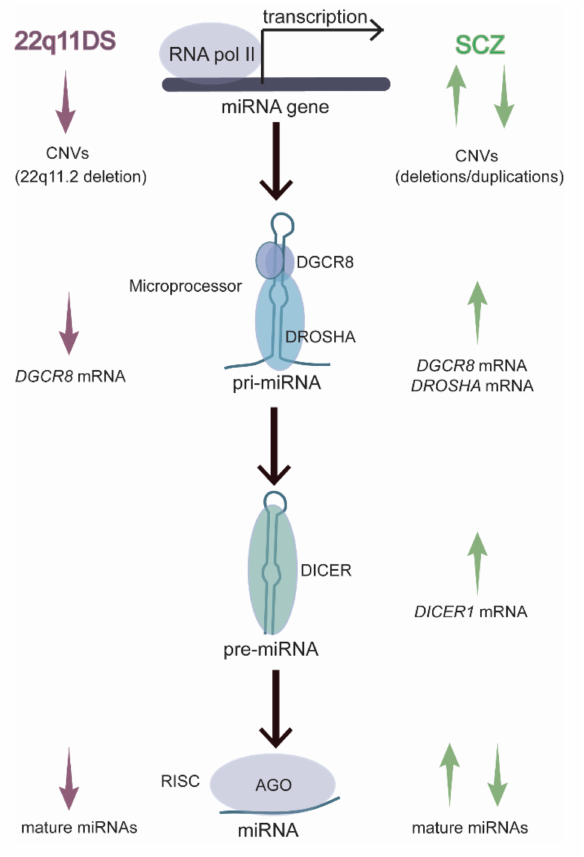
Figure 1. Overview of the miRNA pathway and its dysregulation in 22q11DS and idiopathic SCZ. The miRNA pathway begins when transcription produces a pri-miRNA, which undergoes